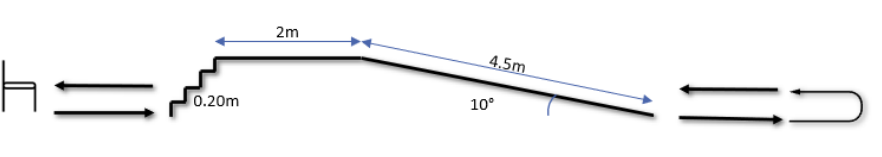
Figure 1. Schematic outline of the measurement set-up. The subject started on the stool, stood up, walked to the stairs, passed over the stairs/ramp combination, walked, turned and walked back to the ramp, passed over the stairs/ramp combination, walked and sat down again. the ramp angle was 10 degrees, the stair step height was 20 cm, stair step length was 22